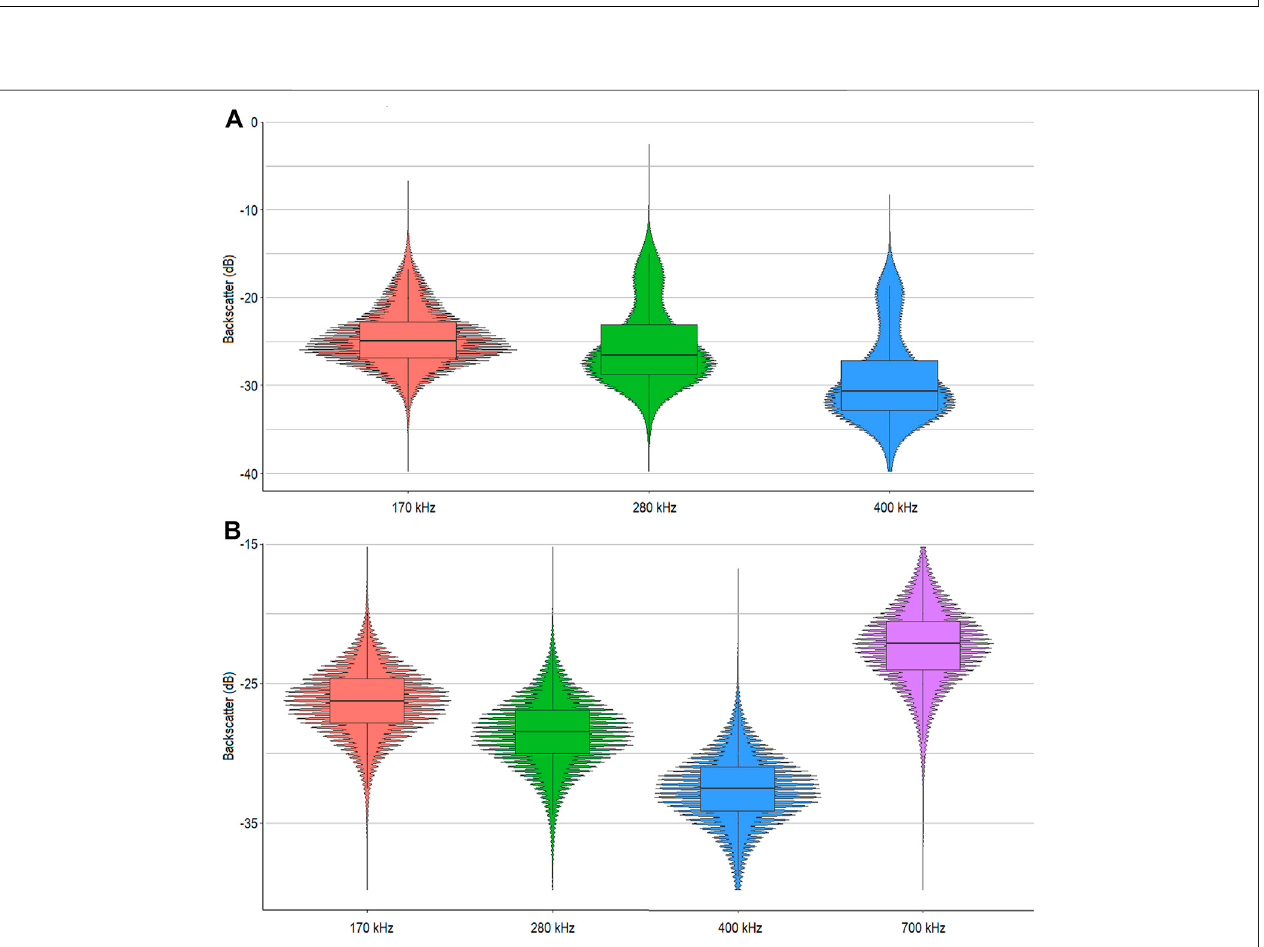
FIGURE 8 | (A) Violin plots presenting backscatter data (170, 280, and 400 kHz) for the whole area, and (B) for all frequencies, spatially restricted within the 700 kHz coverage area.